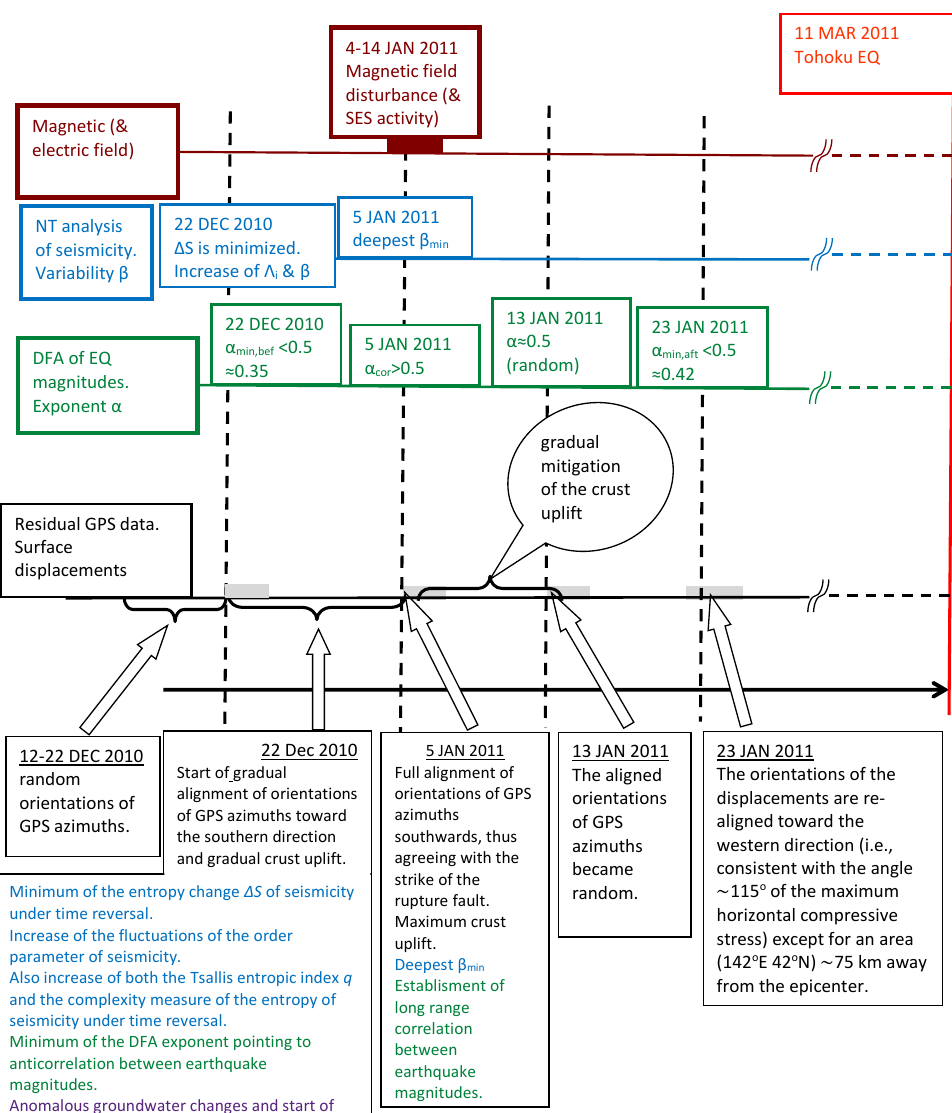
Figure 29. Schematic diagram that compiles the multidisciplinary changes before the Tohoku EQ occurrence. Period: from 12 December 2010 until 23 January 2011. The black letters describe the observations by means of residual GPS data, the brown by anomalous Earth magnetic field variations, green—obtained by DFA, blue—by natural time analysis and purple—by anomalous groundwater and radon changes. Taken from Ref.